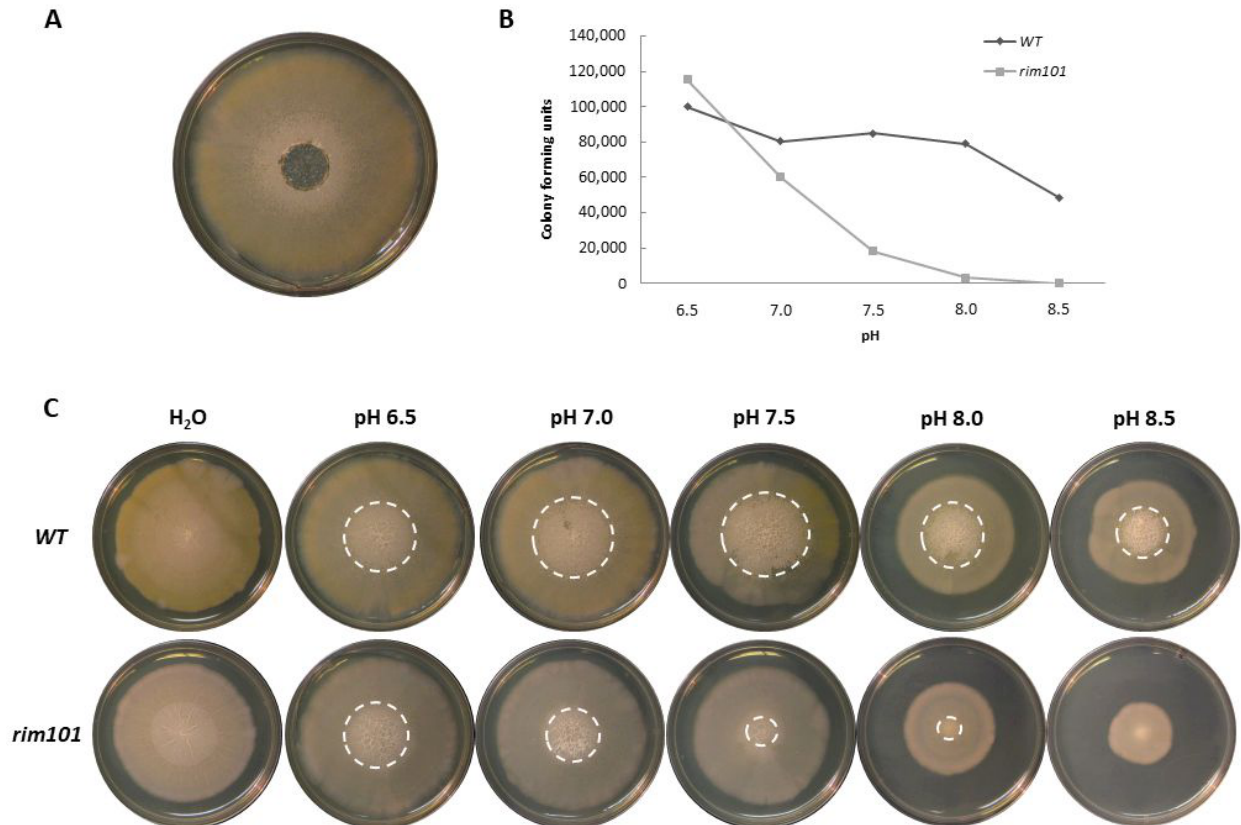
Figure 4. Sporulation ability of the A. gossypii wild-type strain and rim101 mutant at different pH. ( A ) Spores were isolated from the central part of colonies grown for 10 days on a full medium plate. ( B , C ) Sporulation of mycelia on solid media buffered with Tris-HCl to different pH values. ( B ) Spore-forming units were determined by dilution plating of spore suspensions derived from the sporulation zones. ( C ) Sporulation zones of mycelia were marked with white-dotted circles.